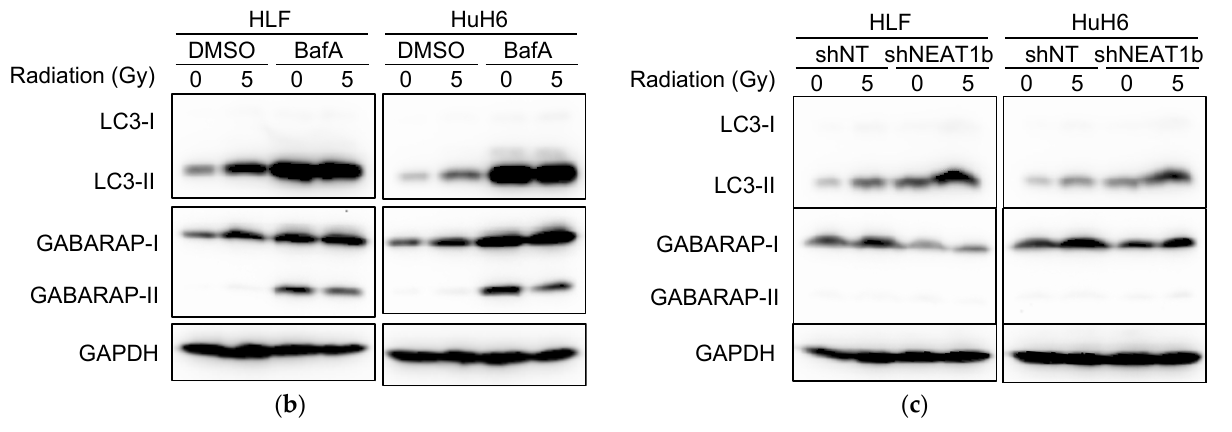
Figure 1. Radiosensitization induced by NEAT1 knockdown in hepatocellular carcinoma (HCC) cell lines. ( a ) Clonogenicity of HLF (left) and HuH6 (right) after X-ray irradiation. Following irradiation, cells were transduced with adenovirus vectors expressing non-targeting (shNT) (open circles) or NEAT1 -targeting shRNAs (shNEAT1a and shNEAT1b; closed rectangles and triangles, respectively). * p < 0.05 vs. shNT; Dunnett’s test ( n = 4). ( b , c ) LC3 protein expression in HLF and HuH6 cells irradiated at 5 Gy. ( b ) Twenty-four hours after irradiation, cells were treated with dimethyl sulfoxide (DMSO) or 50 nM bafilomycin A1 (BafA) for 24 h. ( c ) Following irradiation, cells were immediately transduced with shNT or shNEAT1b adenovirus vectors for 48 h. GAPDH was used as an internal control.